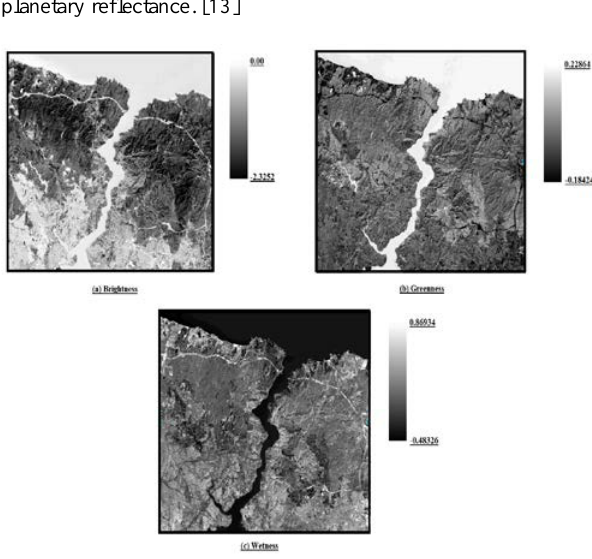
Figure 5. Sample area from TCT Brightness, Greenness, Wetness images for Landsat 8 OLI